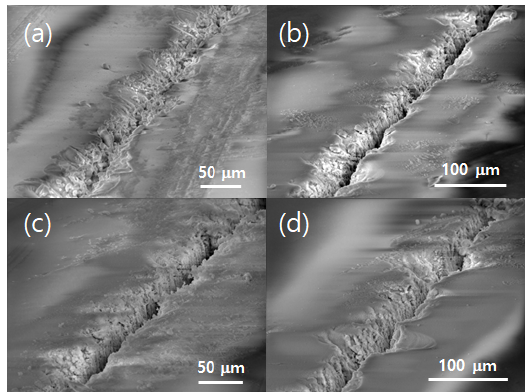
Figure 9. SEM images of the grooves produced by multiple laser scans with zero scan spacing (laser power: 2.28 W, scan speed: 25 mm/s, and pulse repetition rate: 30 kHz). Number of scans: ( a ) 1, ( b ) 5, ( c ) 10, and ( d ) 20.